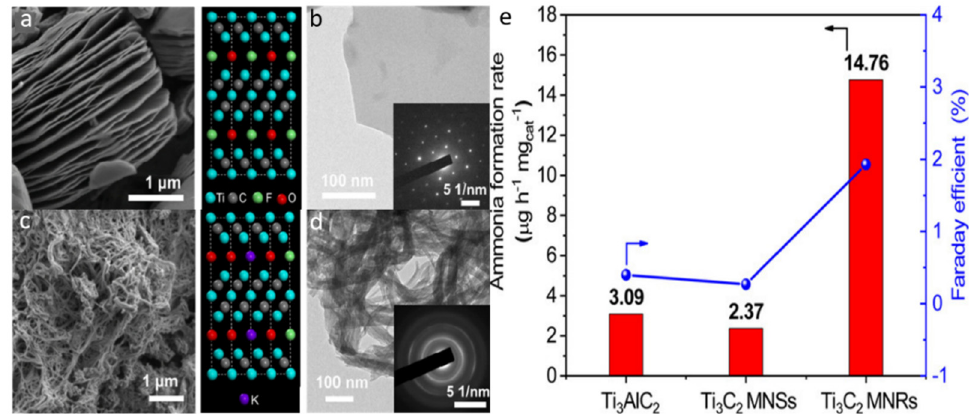
Figure 11. ( a ) SEM micrograph along with structural model, and ( b ) top view of TEM micrograph with the SAED pattern of the Ti 3 C 2 MNSs in the inset. ( c ) SEM micrograph along with structural model, and ( d ) TEM micrograph with SAED pattern of the Ti 3 C 2 MNRs in the inset. ( e ) Formation of ammonia and the faradaic e ffi ciency with various electrodes at − 0.5 V potential versus the RHE after electrocatalytic tests for 3 h at room temperature. Reproduced with permission from ref. [148] Copyright 2020, Willey.